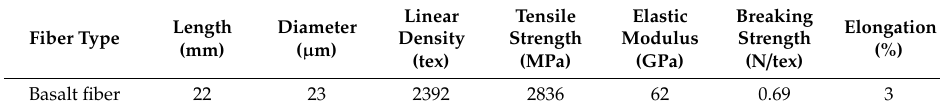
Table 2. Basic properties of basalt fibers.